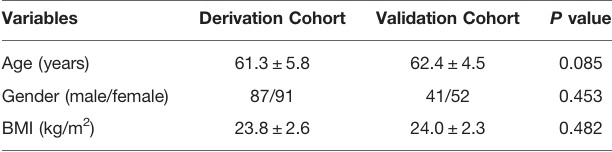
TABLE 4 | Demographic characteristics of the 2 cohorts.